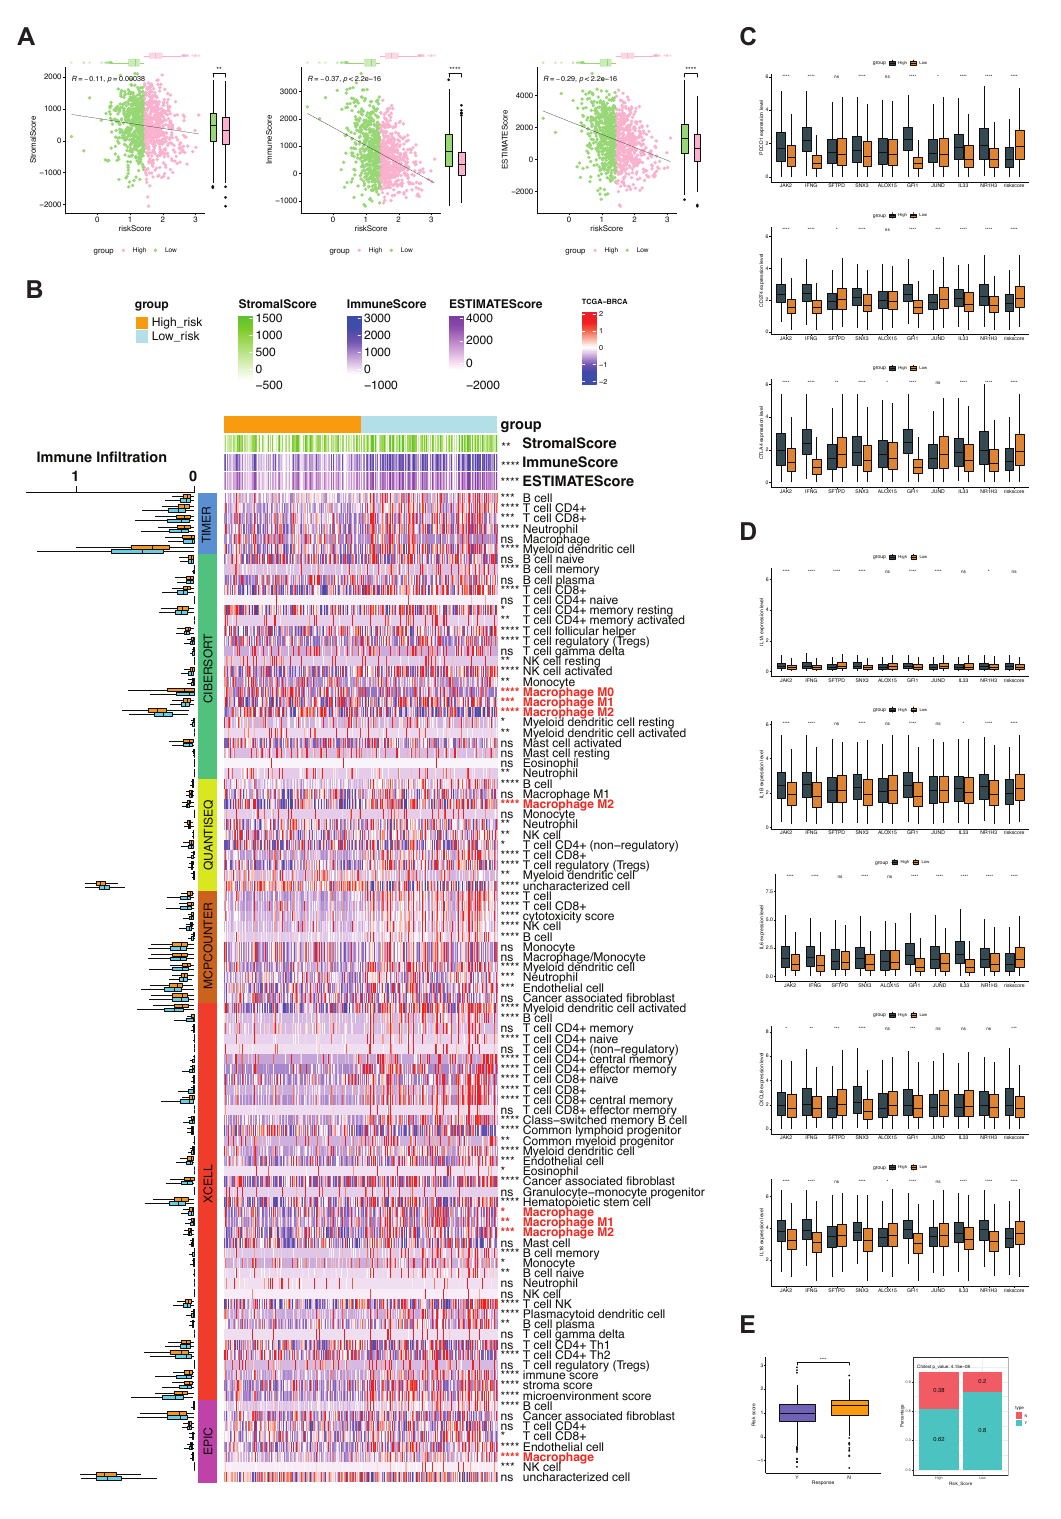
Figure 14. Immune correlates of phagocytosis factor signatures. ( A ) Correlation between risk score, matrix score, immune score, and estimate score; ( B ) differences in immune cell infiltration between risk score groups; ( C ) immune checkpoints; ( D ) correlated expression of proinflammatory factors, phagocytosis factors, and risk score; ( E ) correlation of phagocytosis factor risk score with drug treatment response in the immunotherapy cohort. (* p < 0.05, ** p < 0.01, *** p < 0.001, **** p < 0.0001, and ns p value >